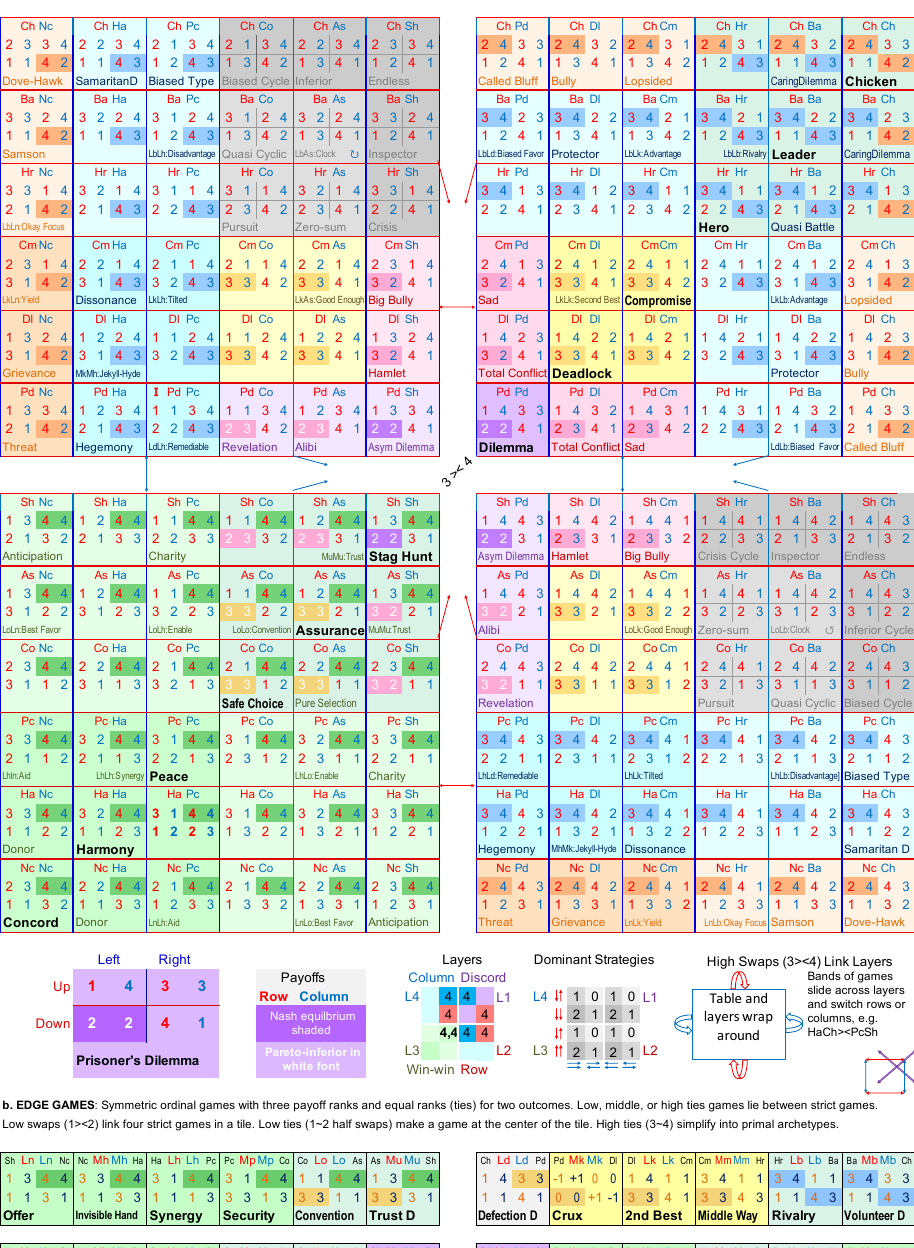
Figure A4. A periodic table of elementary social situations, based on the topology of 2x2 games. Dominant strategy layout of strict ordinal games above. Games with ties below. a. STRICT GAMES : Two-person, two-move (2x2) ordinal games with four payoff ranks, mapped in the Robinson-Goforth topology of 2x2 games. Symmetric games on diagonal axis, payoffs combine to make asymmetric games. Swaps in outcome ranks link neighboring games (1><2, 2><3, 3><4).